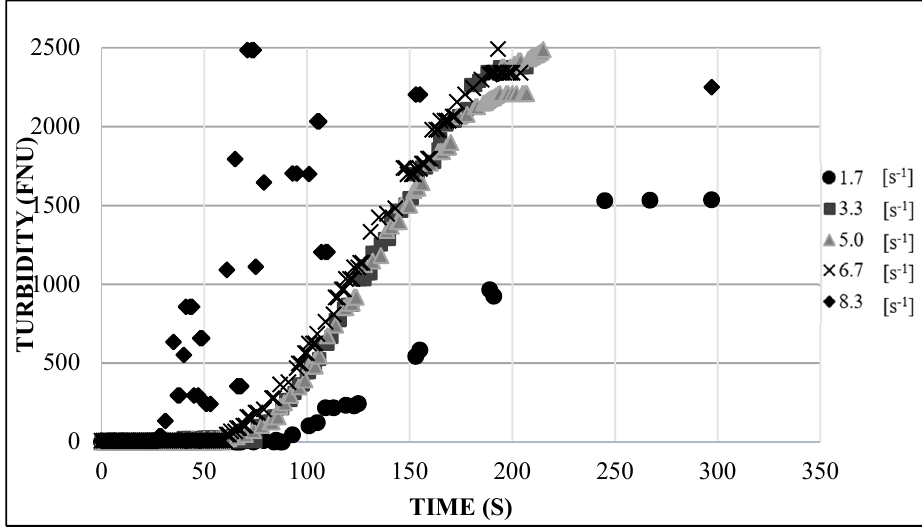
Figure 5. Induction time as a function of temperature.